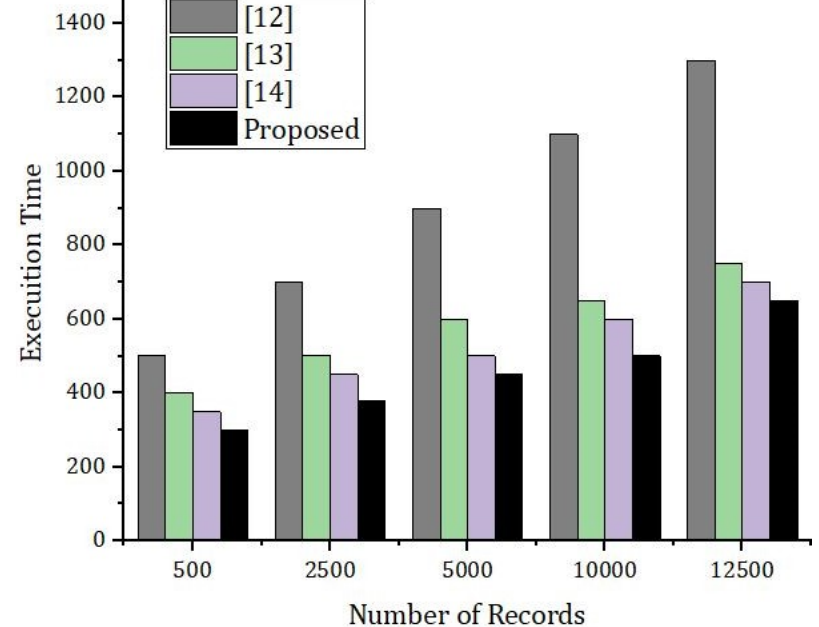
Figure 17. Simulation results based on the execution time and the cache hit rate.